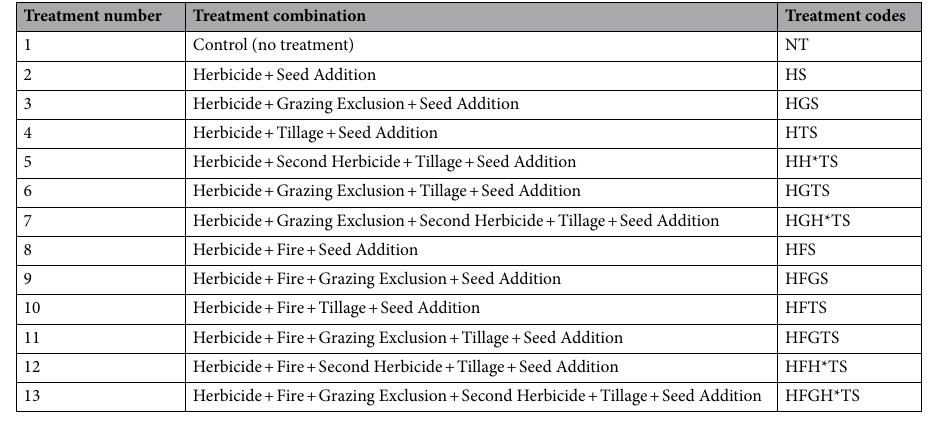
Table 1. The 13 integrated treatment combinations and the associated treatment